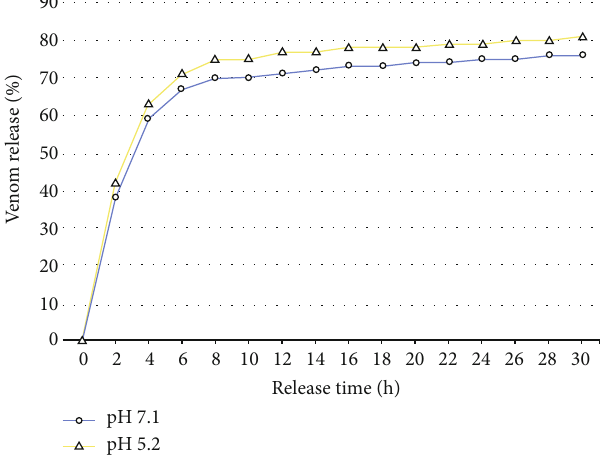
Figure 3: Bee venom release pro fi le from fungal chitosan nanoparticles at di ff erent pH values (5.2 and 7.1) during the 30 h releasing period.